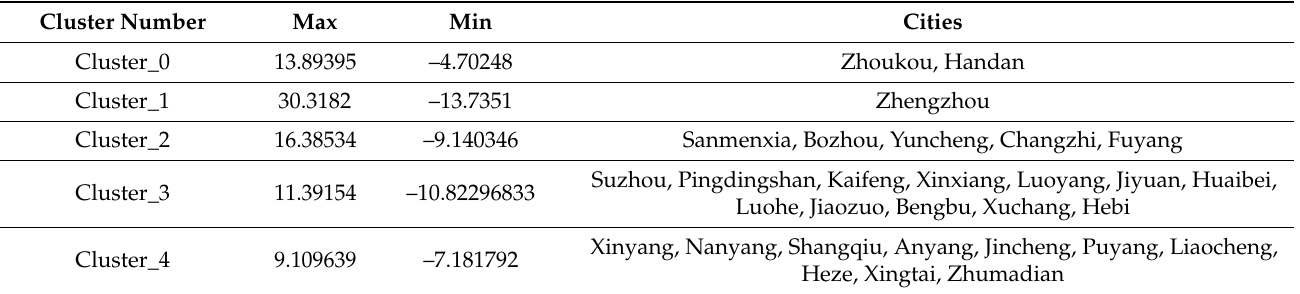
Table 4. Clustering results based on